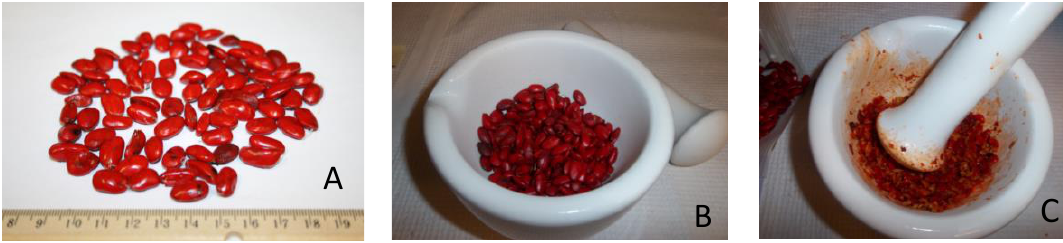
Figure 5. Study material. A : Seeds were separated from mature fruits; B : seeds were prepared and gently crushed in a mortar and pestle ( C ), and were subsequently hydrodistilled. Photos courtesy of V.R and N.T.